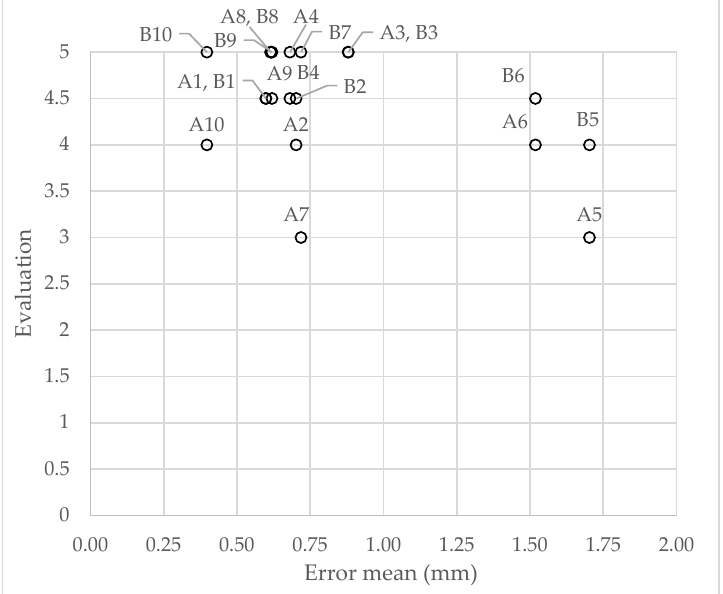
Figure 4. Scatter plot with the 20 pairs of values and labels corresponding to the mean distance for each patient (from patient 1 to 10) and its evaluation from each surgeon (A and B). A comma is used when evaluation from both surgeons coincided for a patient (for example A1, B1).